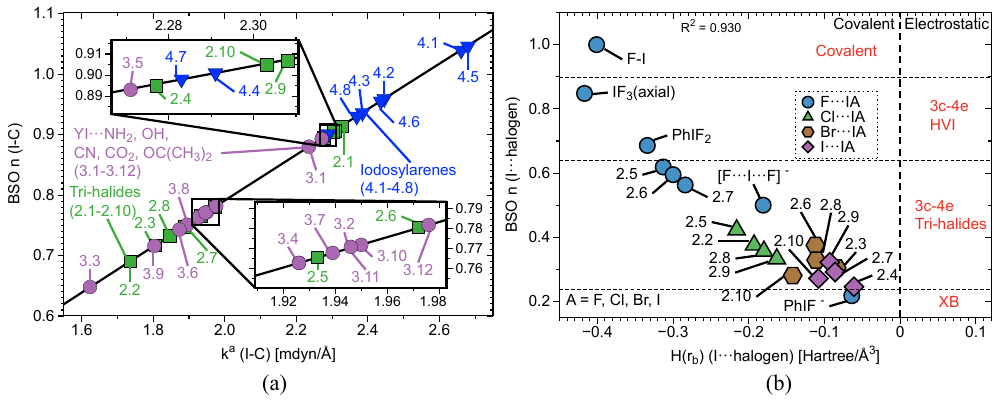
Figure 4. ( a ) BSO n versus ( k a ) of I–Ph ( 2.1–3.12 ) and I-benzene ( Group 4 ) according to eq 2. BSO n for the equatorial I–C bonds has been scaled by a factor of 1.517. ( b ) Comparison of BSO n with H ( r b ) of all halogen–iodine interactions in complexes 1.1–2.10 . The vertical dashed line separates the electrostatic region from the covalent